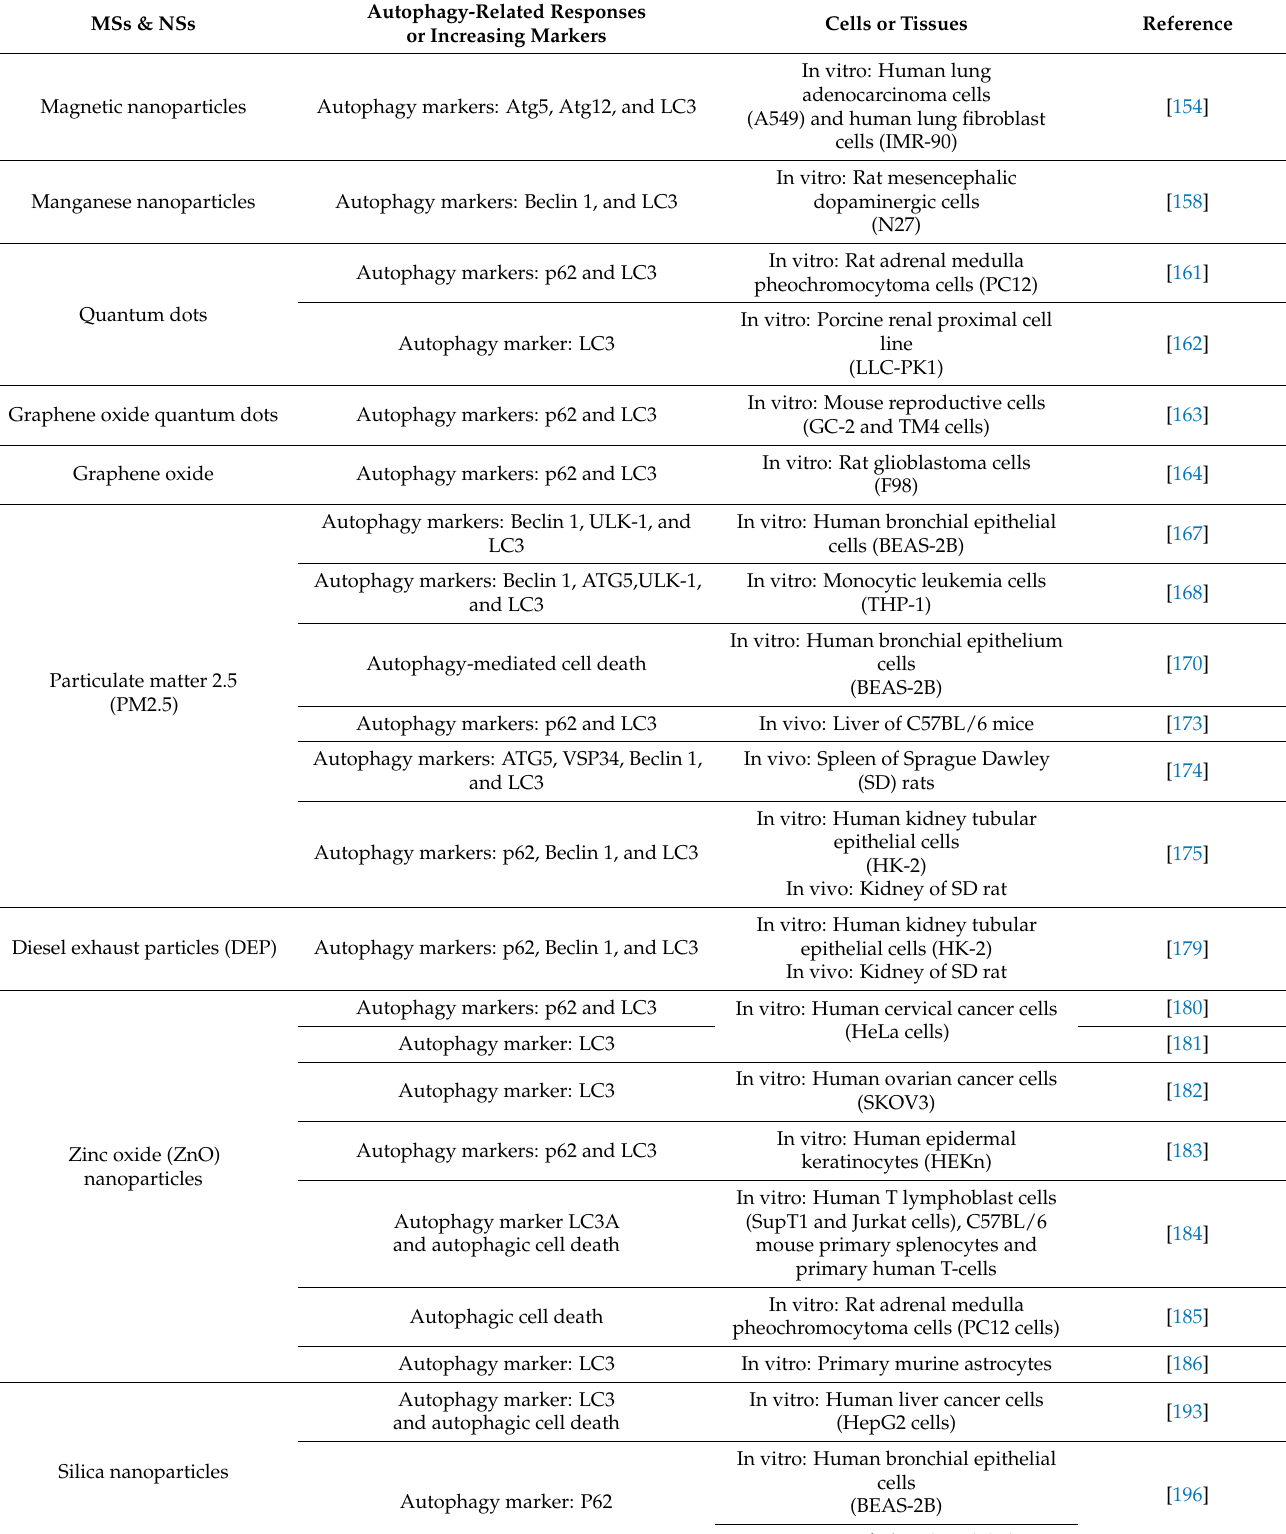
Table 1. MSs & NSs of autophagy-related responses in cells or